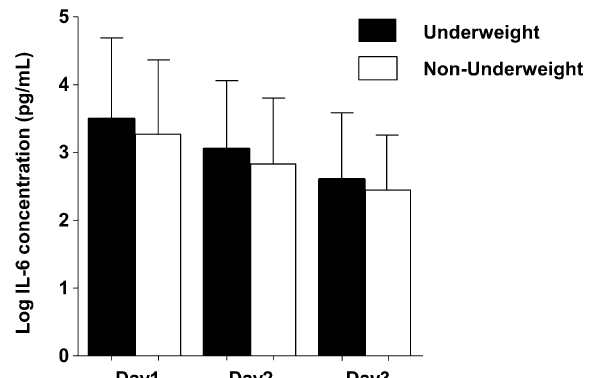
Figure 1. Comparison of blood IL-6 levels between the underweight (BMI < 18.5) and non-underweight (BMI ≥ 18.5) group at days 1, 2, and 3. There was a non-significant trend of increased blood IL-6 levels in the underweight group compared to the non-underweight group in a generalized estimating equation using log- converted serum IL-6 concentration at days 1, 2, and 3 ( p = 0.088, adjusted OR 1.24, 95% CI 0.96–1.60). IL interleukin, BMI body mass